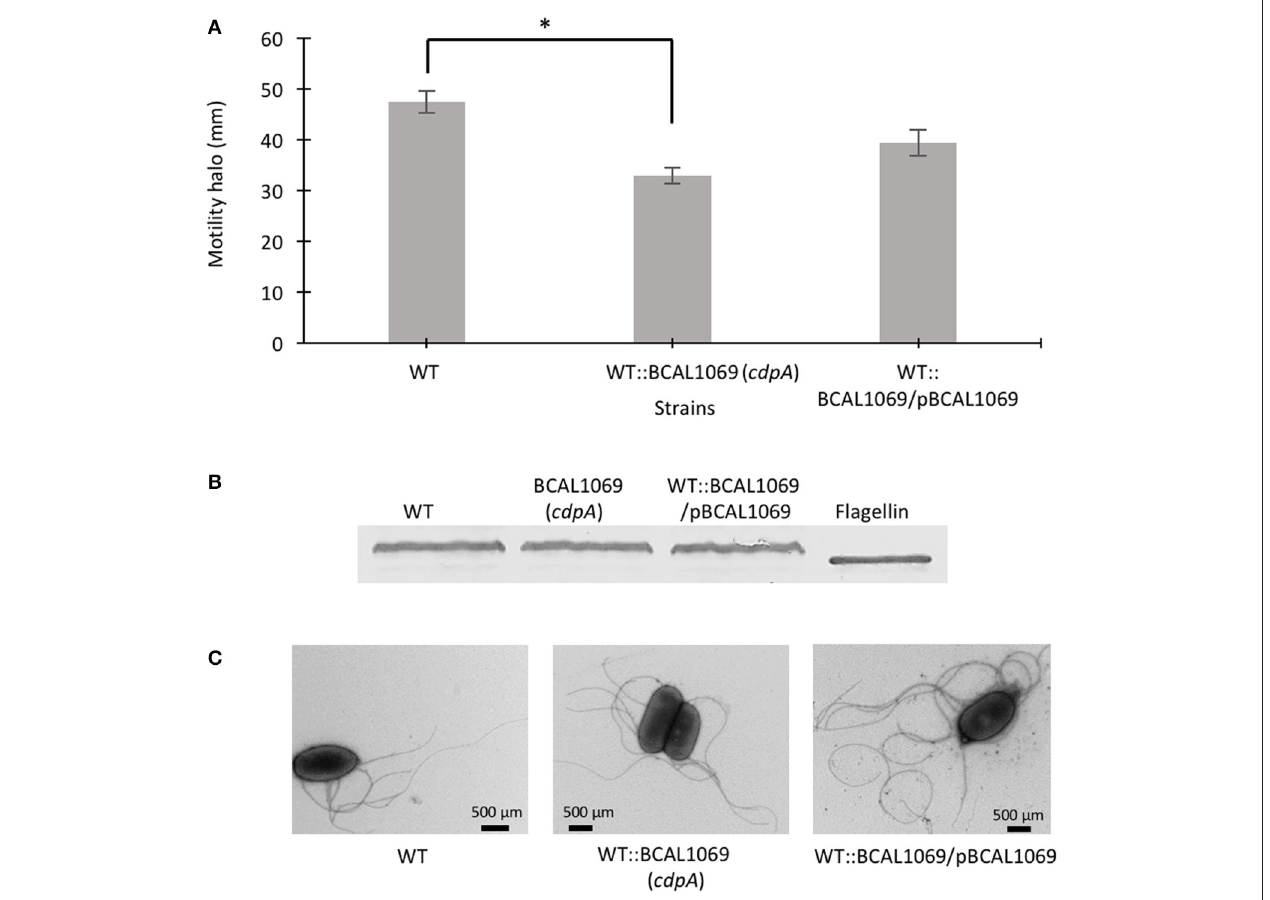
FIGURE 3 | Role of BCAL1069 ( cdpA ) motility in swimming motility. (A) The swimming motility of the strains was examined in semi-solid SCFM 0.3% agar plates at 37 ◦ C after 24h. The motility assay was performed three-times independently in duplicates (* p < 0.01). (B) To detect flagellin protein, proteins from whole cell lysates of strains were separated on 12% SDS-PAGE followed by flagellin detection using anti-flagellin primary antibody and alkaline phosphatase cross linked to secondary antibody. Western blots were performed twice. One representative experiment is shown. (C) The presence of flagella in the WT and mutant strains were observed using transmission electron